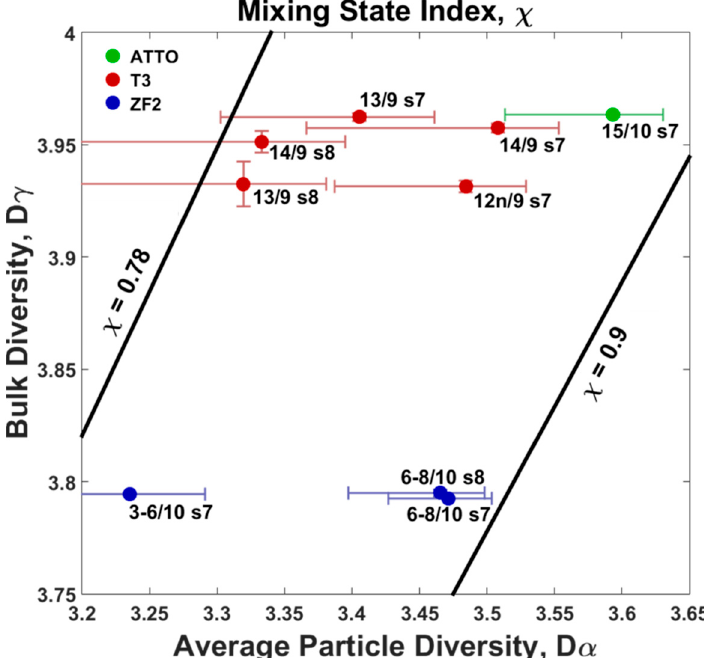
Figure 9. Mixing state index of each sample (color coded by site) with associated error bars, adjusted to one-tenth of their size for readability. All average particle diversities are not significantly different. The site ZF2 bulk diversities are significantly different from the T3 and ATTO bulk diversities. Samples are labeled with day/month and stage number. The horizontal and vertical axes are essentially the numerator and denominator of the definition of χ (refer to Equation (14)).